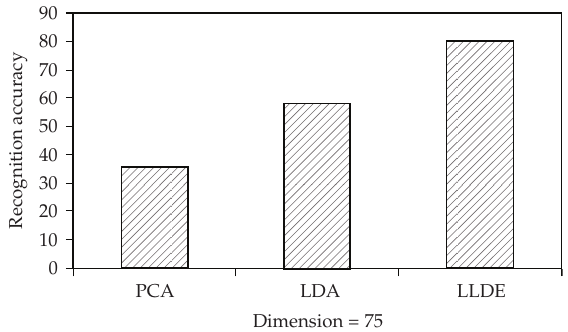
Figure 5: The average recognition rates of the PCA, LDA, and LLDE, across 10 tests (cid:2) dimension 75 (cid:3) .